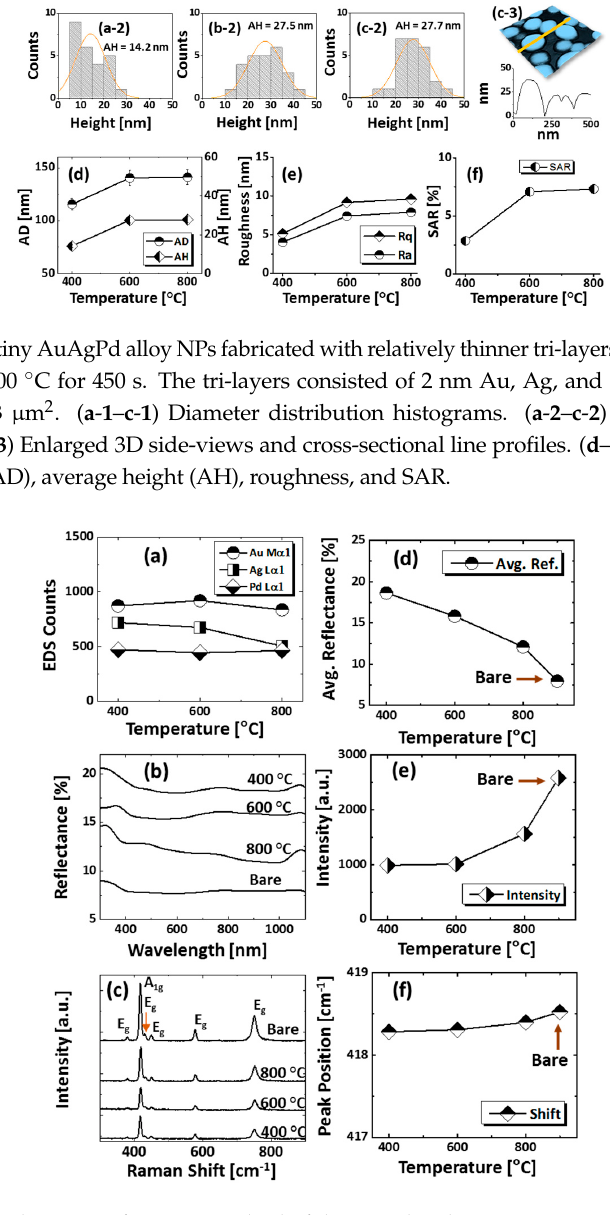
Figure 5. ( a ) EDS peak counts of Au, Ag, and Pd of the samples shown in Figure 4. ( b ) Corresponding reflectance spectra. ( c ) Raman spectra. ( d – f ) Summary plots of average reflectance, Raman intensity, and Raman peak position with respect to the temperature.